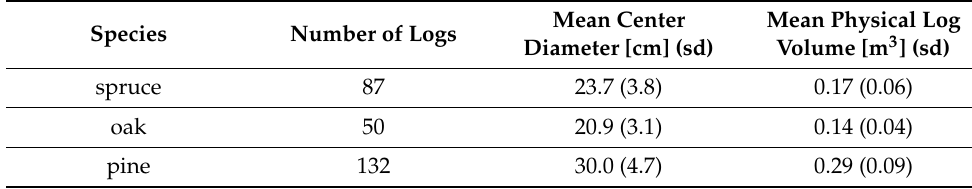
Table 1. Summary of the observed logs (data from manual measurement).